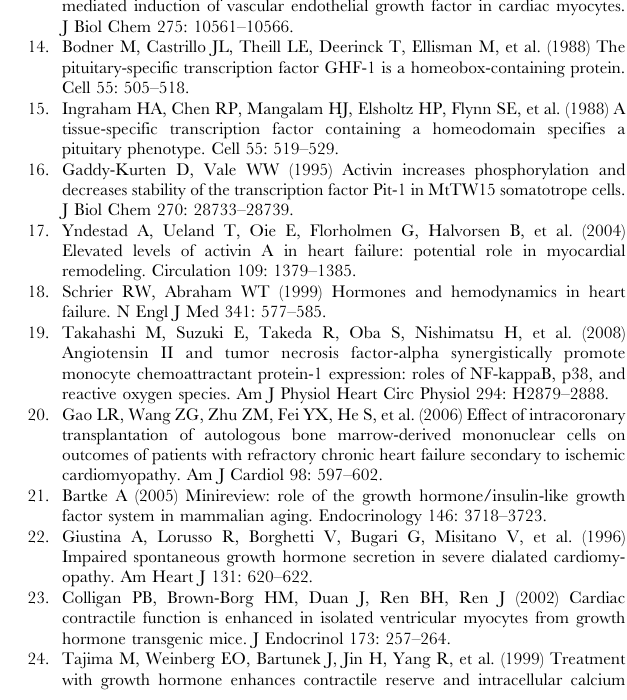
Lower photographs, representative images. Scale bar, 75 m m. Data are means 6 s.e.m. (TIF) Figure S4 Flow cytometric analysis. The left and right panels show the expression of each cell surface marker before and after magnetic sorting (MACS), respectively. (TIF) Figure S5 Cardiac hypertrophy in vitro . Upper graph, cell surface area of neonatal rat cardiomyocytes ( n =50); lower photographs, representative images of the cells. Cardiomyocytes were stained with sarcomeric a -actinin (red). Nuclei were stained with Hoechst 33258 (blue). Scale bars, 75 m m. Data are means 6 s.e.m. (TIF) Figure S6 Comparison of GH concentration. GH concen- tration in CM from Gr-1( + ) cells isolated from old myocardial infarction (OMI) mice and DOX mice ( n = 5). Data are means 6 s.e.m. (TIF) Figure S7 BMMNC improve the cardiac function of OMI mice via the GH receptor. (A) At 4 weeks after coronary ligation, BMMNC were infused via the tail vein. Pegvisomant (10 mg/kg body weight) or vehicle (control) was intraperitoneally injected into OMI mice 30 min before infusing BMMNC. BMMNC infusion improved FS and + dp/dt at 3 d after infusion and these improvements were inhibited by pegvisomant (n= 5). (B) Masson trichrome staining. Panels show representative images. Scale bars: 1 mm. Data are means 6 s.e.m. (TIF) Figure S8 Direct effects of GH in the CM from Gr-1( + ) cells on cardiomyocytes. CM from Gr-1( + ) cells from wild-type mice was infused into DOX-treated wild-type mice (wild-DOX) or DOX-treated cardiac-specific STAT3dn mice (STAT3dn-DOX).